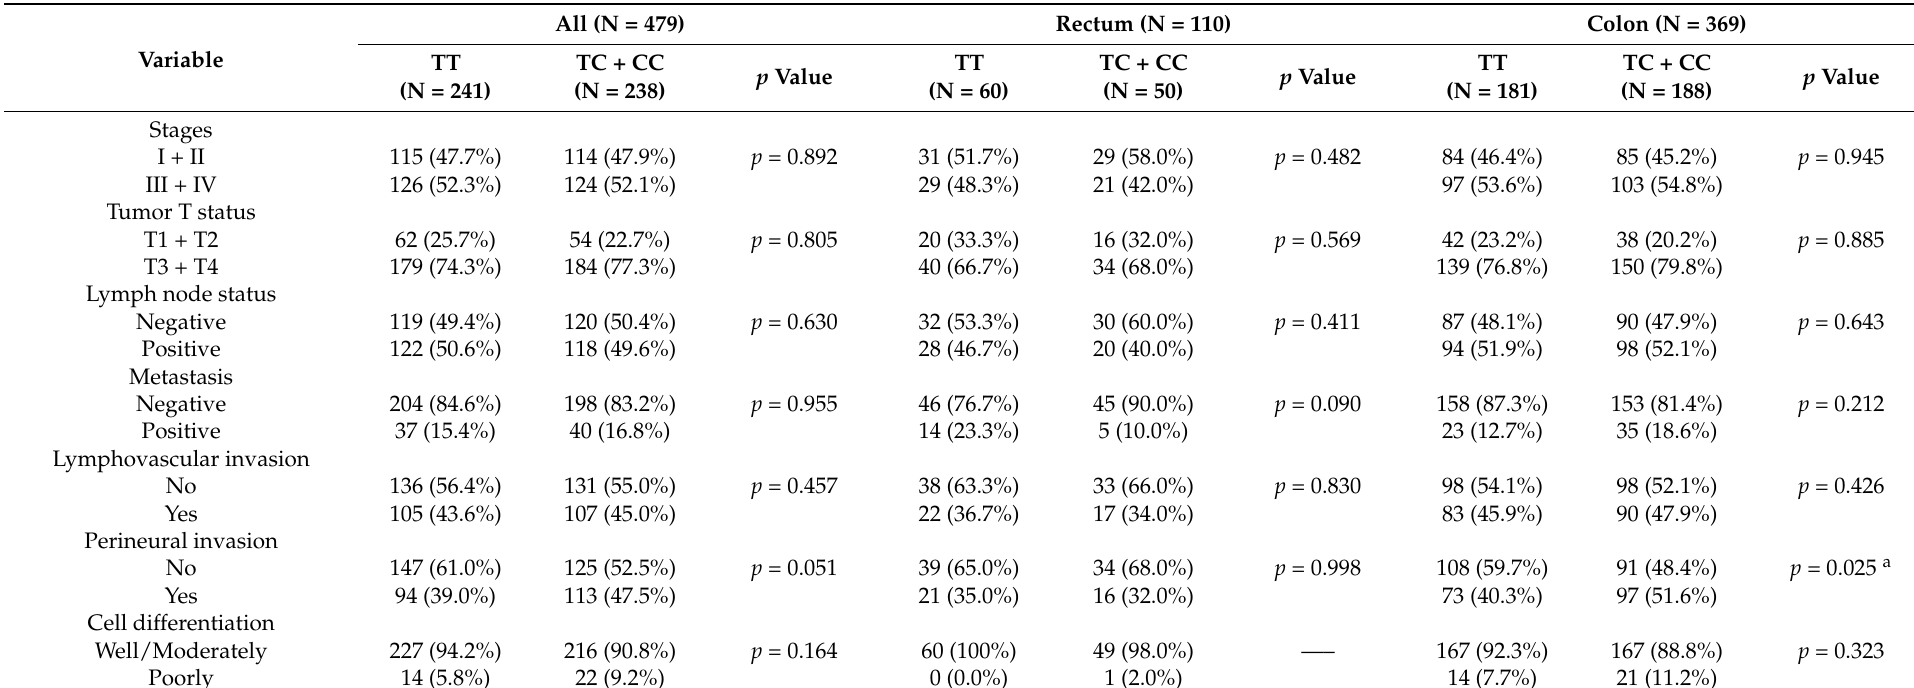
Table 3. Distribution frequency of the clinical status and MMP-11 rs738792 genotype frequencies in 479 CRC